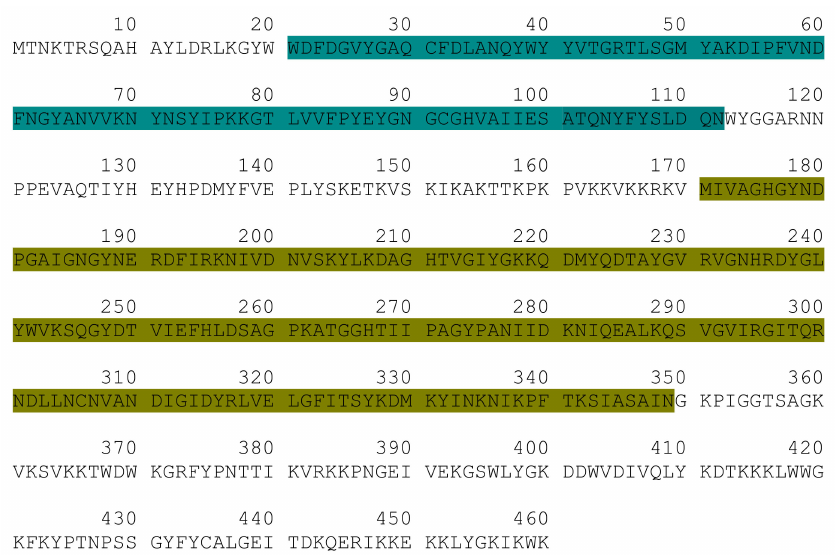
Figure 2. Schematic representation of the Ph28 endolysin sequence. The CHAP domain, is colored teal. The MurNac-LAA domain is colored dark